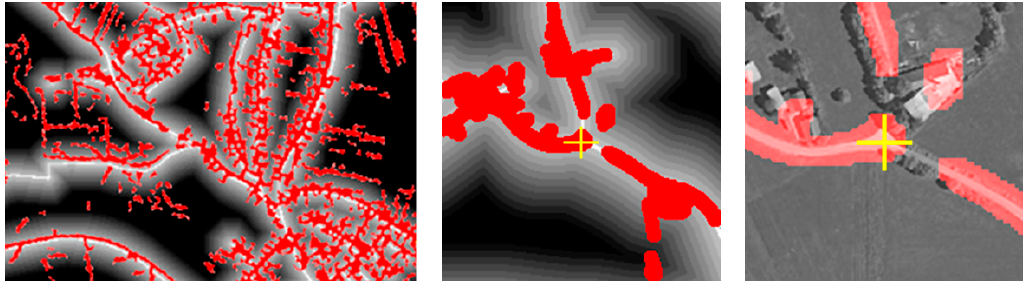
Figure 5. Examples of the three GCP extraction steps: Coarse matching of the roadmask tile onto the road distance image ( left ). Fine positioning of the GCP onto the road distance image ( centre ). Super-fine positioning onto the aerial orthophoto, described in Section 3.2 ( right ). The roadmask ( i.e. , road candidates extracted from the satellite image) is superimposed onto the background road distance image or orthophoto; the GCP position is displayed with a cross. The grayscale values of the road distance image represent a non-linear function of distance to the closest actual road at which white colour represents the minimum (zero) distance, and black represents the maximum distance.